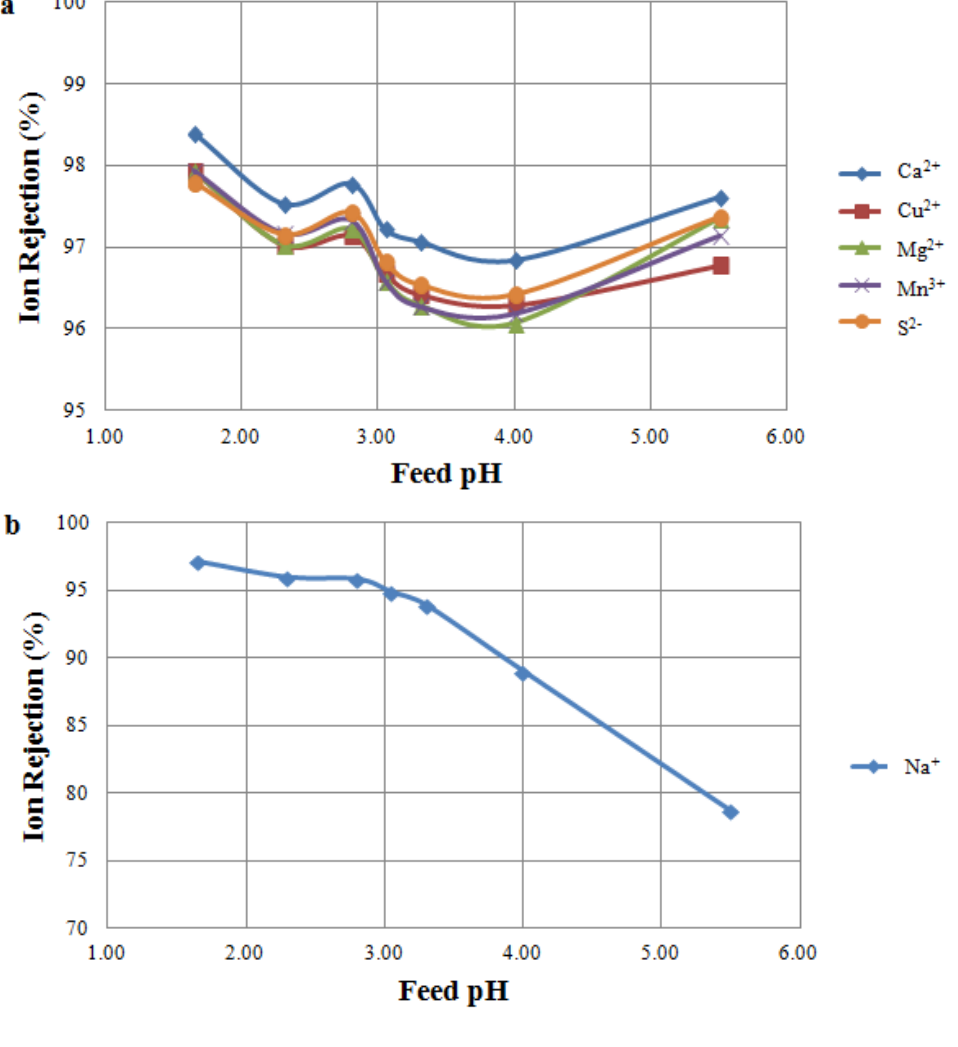
Figure 4. Ion rejection at varying feed pH as a result of MW Tests. Tested feed solution: MW B. Tested membrane: TS 80 membrane. ( a ) Rejection of multivalent ions; ( b ) Rejection of sodium